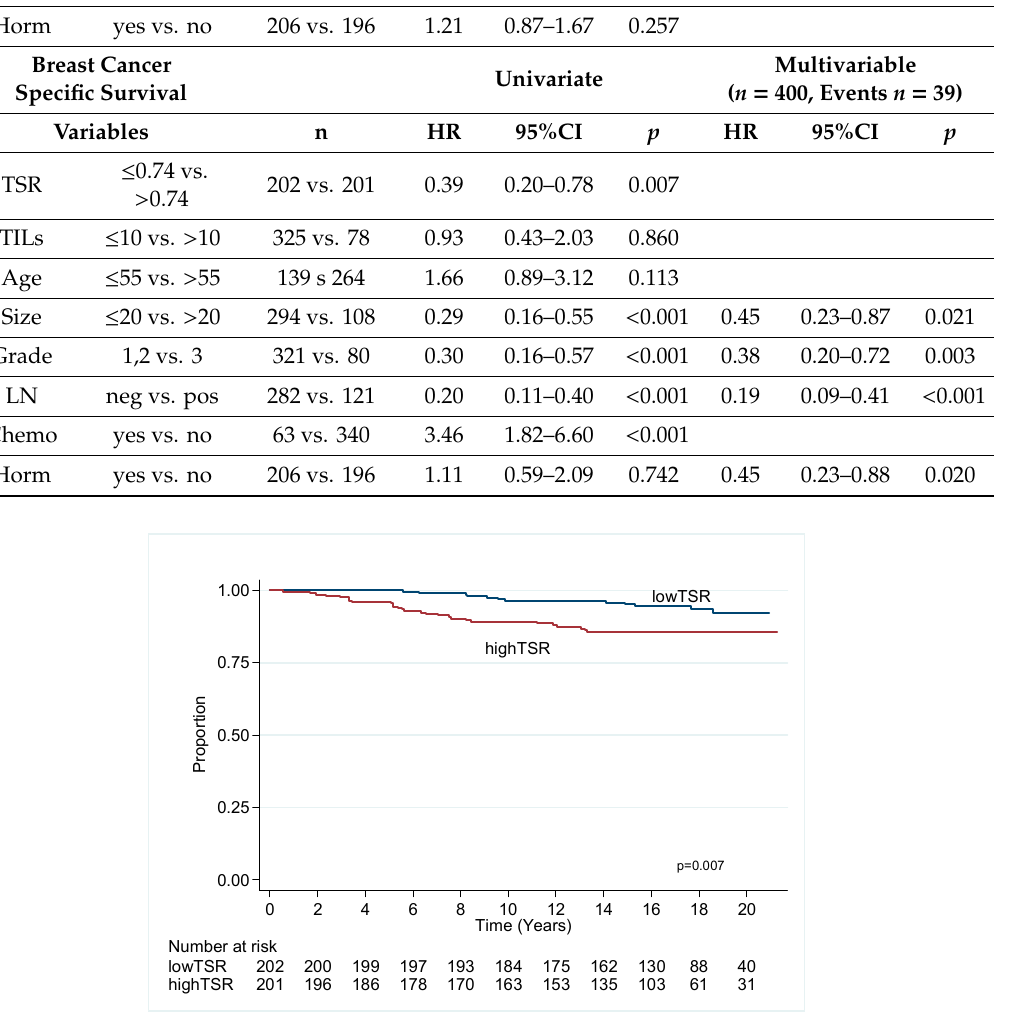
Figure 4. Kaplan–Meier plot of TSR for luminal ER + cancer, breast cancer specific survival. Endocrine Therapy and TSR